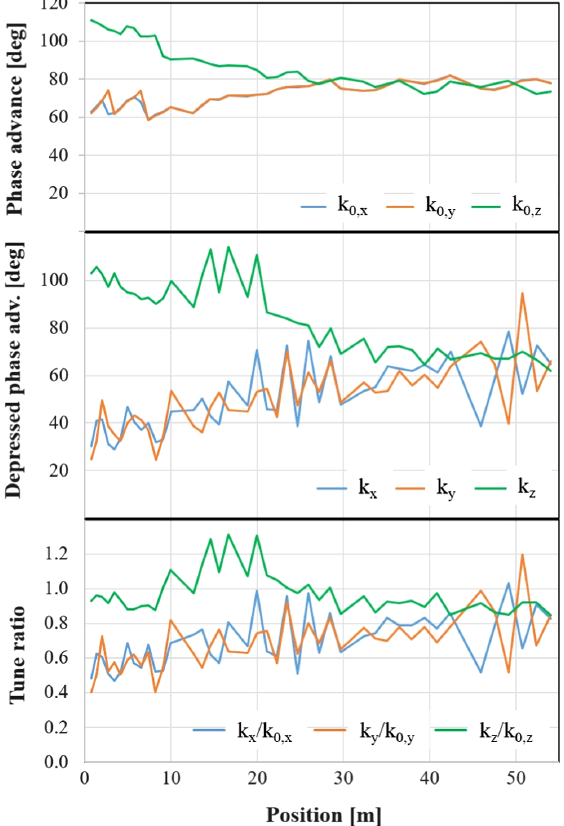
FIG. 12. Zero current phase advance, depressed phase advance, and tune depression for the complete DTL with intercavity sections and k 0 ;t ¼ 65 °, k 0 ;z ¼ 120